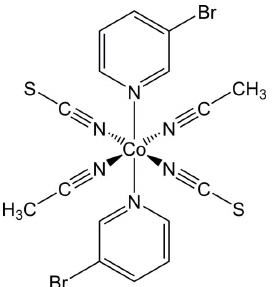
Figure 1 Crystal structure of the title compound with atom labeling and displacement ellipsoids drawn at the 50% probability level. Symmetry code: (i) (cid:3) x + 1, (cid:3) y + 1, (cid:3) z + 1. The disorder of the methyl H atoms is shown as full and open